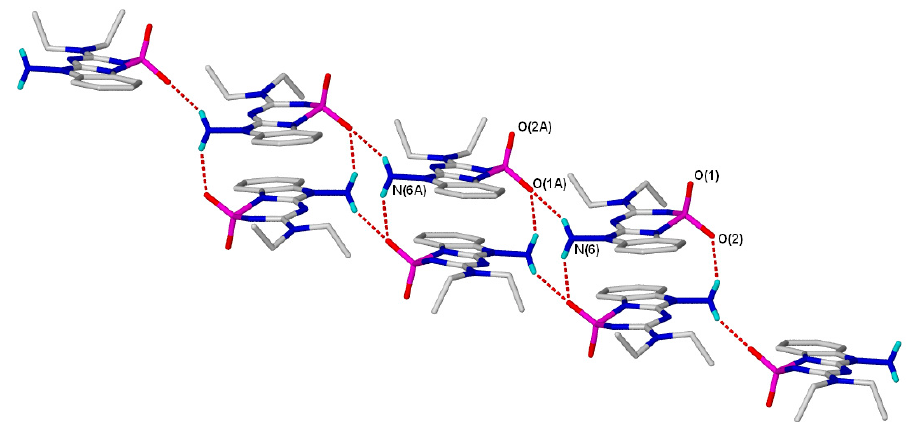
Figure 2. Stick plot of the linear chain crystal packing of 6 .